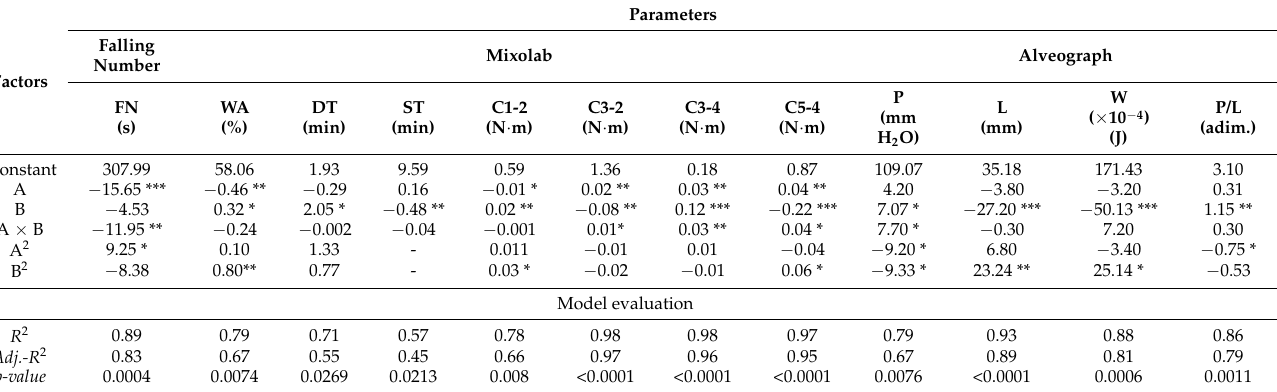
Table 2. The coefficients in the predictive models for FN index, Mixolab, and Alveograph parameter.